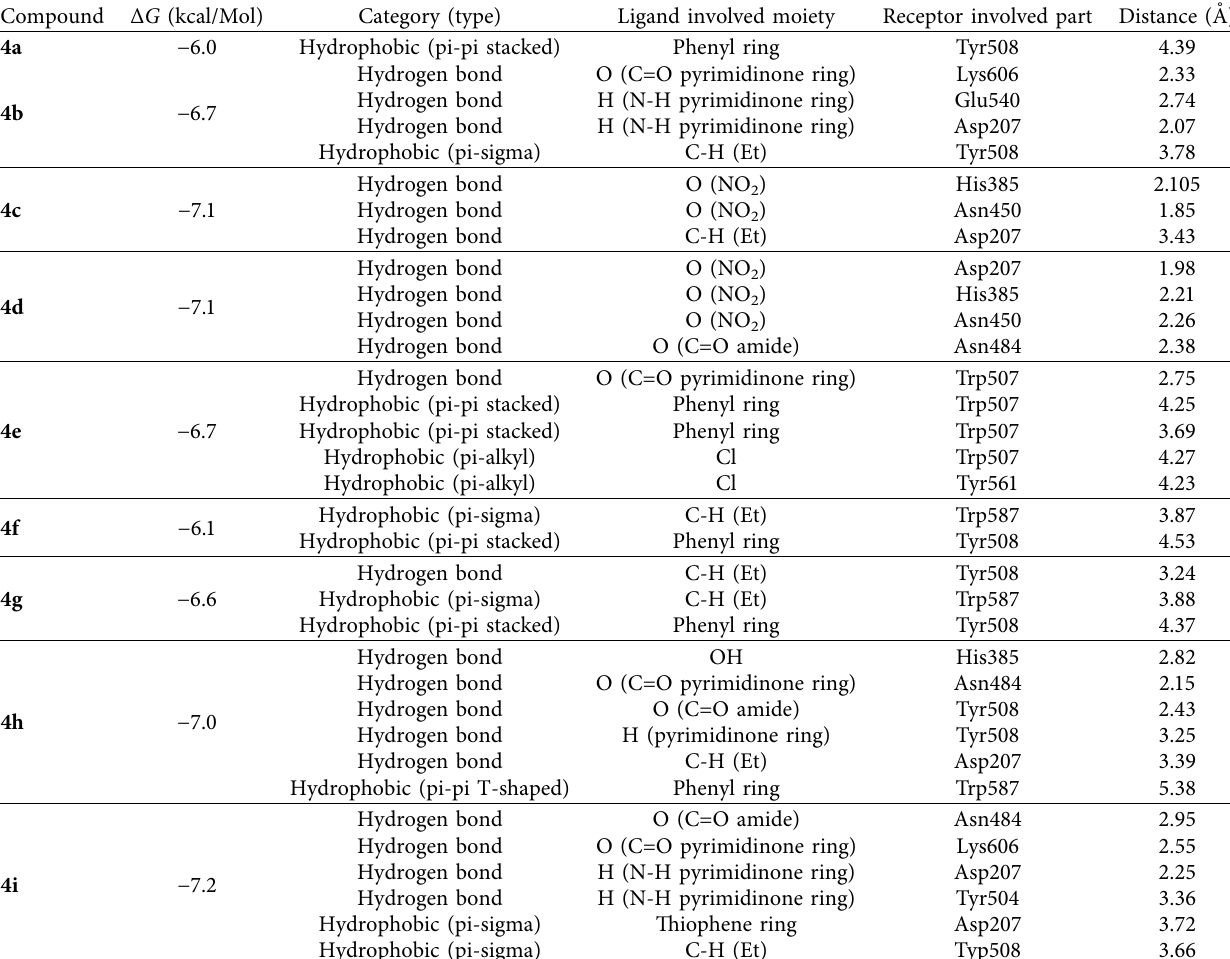
Table 2: Docking energies and interactions of compounds against the β -glucuronidase enzyme.